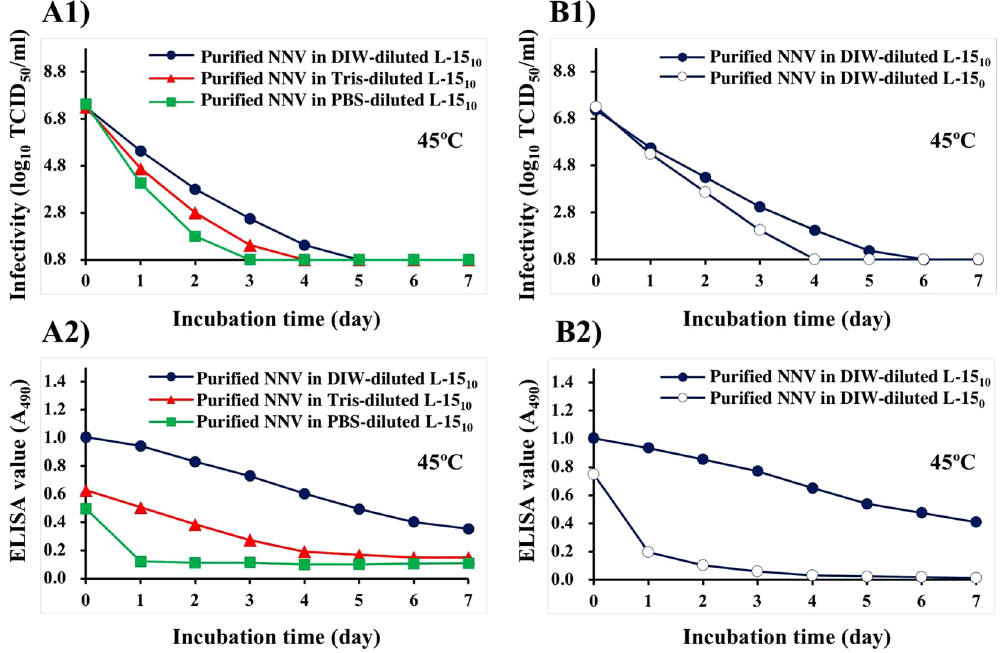
Figure 4. Effect of purified NNV particles suspended in L-15 10 or L-15 0 media diluted 320-fold with DIW, Tris- HCl (15 mM, pH 8.0), or PBS. Purified NNV particles suspended in each buffer were incubated at 45 °C for 7 days. ( A ) Purified NNV particles suspended in L-15 10 media diluted 320-fold with DIW, Tris-HCl, or PBS, ( B ) Purified NNV particles suspended in L-15 10 or L-15 0 diluted 320-fold with DIW. (1) Infectivity changes of NNV particles, (2) Antigenicity changes of NNV